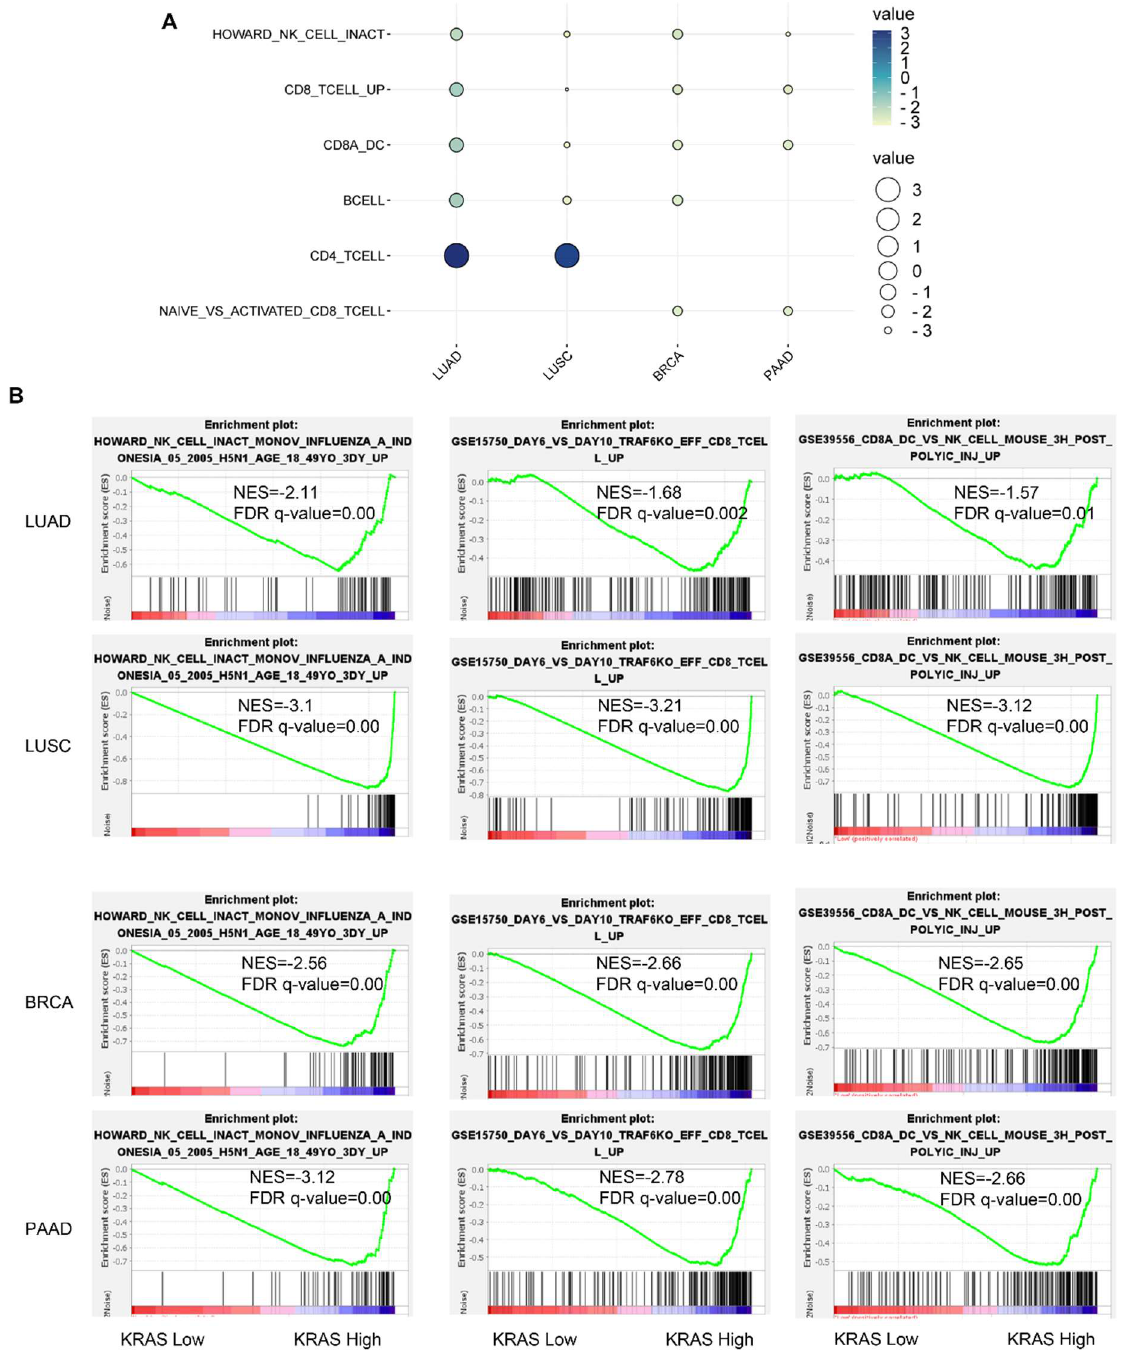
Figure 11. Immunological signature gene set analysis of KRAS-low vs. KRAS-high datasets in LUAD, LUSC, BRCA, and PAAD. A, Bubble plot showing common gene signatures of immune cell infiltration among LUAD, LUSC, BRCA, and PAAD. B, NK cell, CD8+T cell, and CD8A_Dentritic cell_NK cell infiltration signatures are enriched in LUAD, LUSC, BRCA, and PAAD. A FDR q -value < 0.05 was considered a significant threshold.